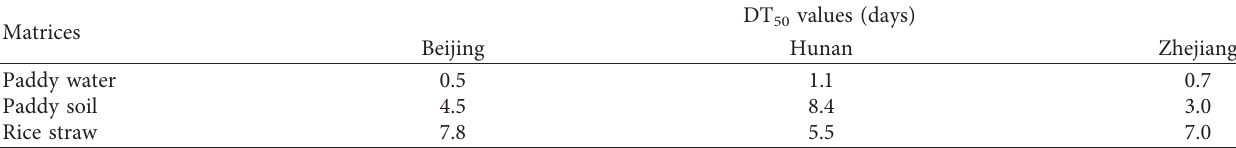
Table 5: The DT 50 values of indoxacarb in different matrices in Beijing, Hunan, and Zhejiang.